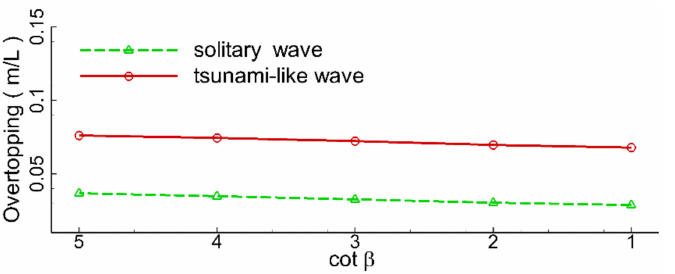
Figure 26. Variations in the maximum overtopping volume with the side slopes of the seawall.